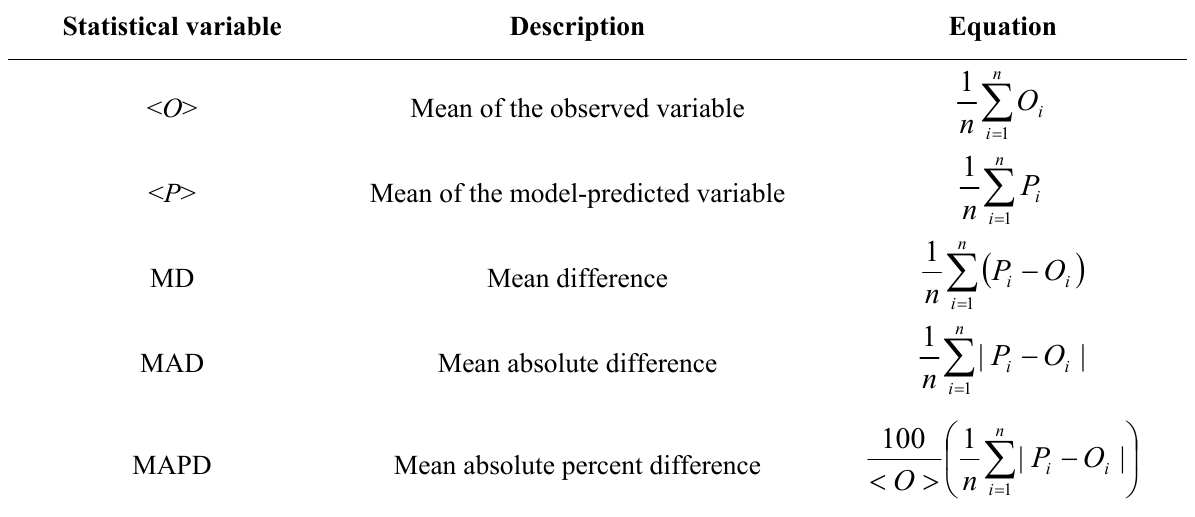
Table 1. Description of the statistics used in assessing the model